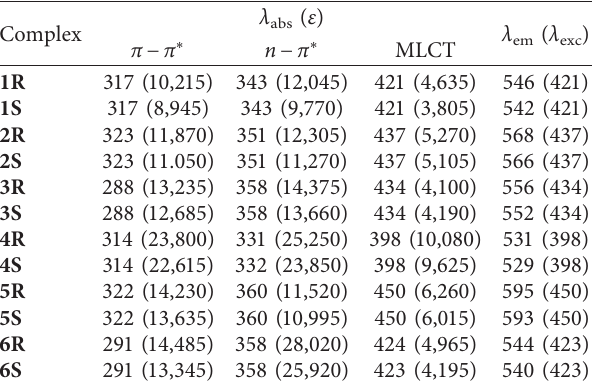
Table 1: Photophysical data of the chiral salen platinum(II) complexes.